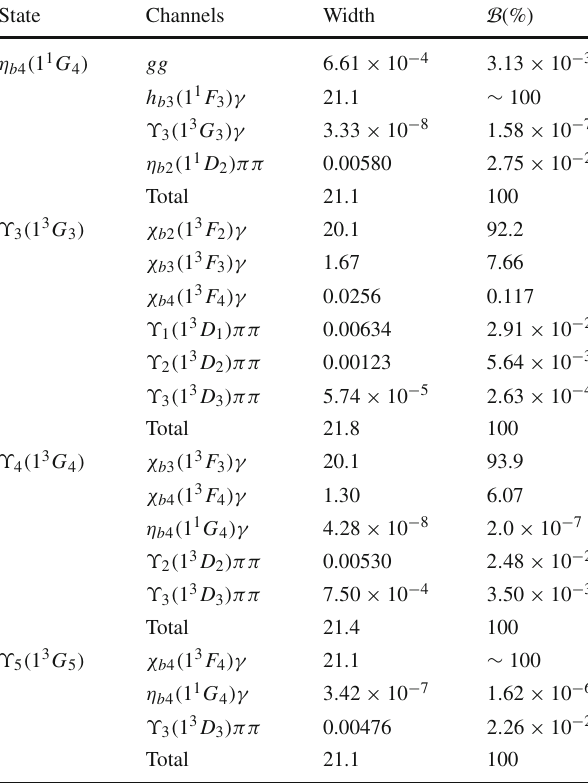
Table 14 Partial widths and branching ratios of annihilation decay, radiative transition, and hadronic transition and total widths for the 1 G bottomonium states. The widths are in units of